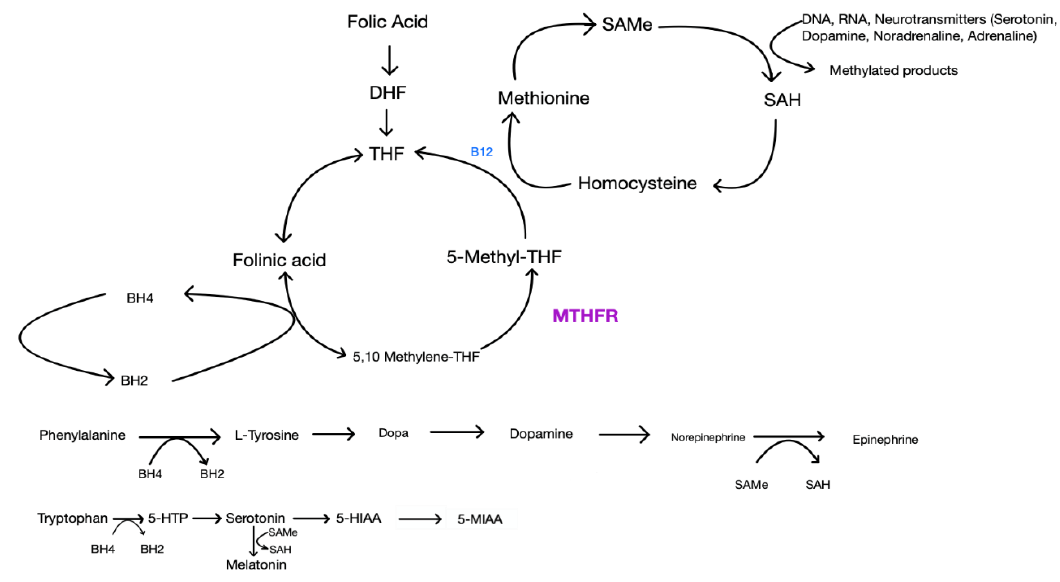
Figure 1. Folic acid pathway and other critical pathways involved in neurotransmitter synthesis.